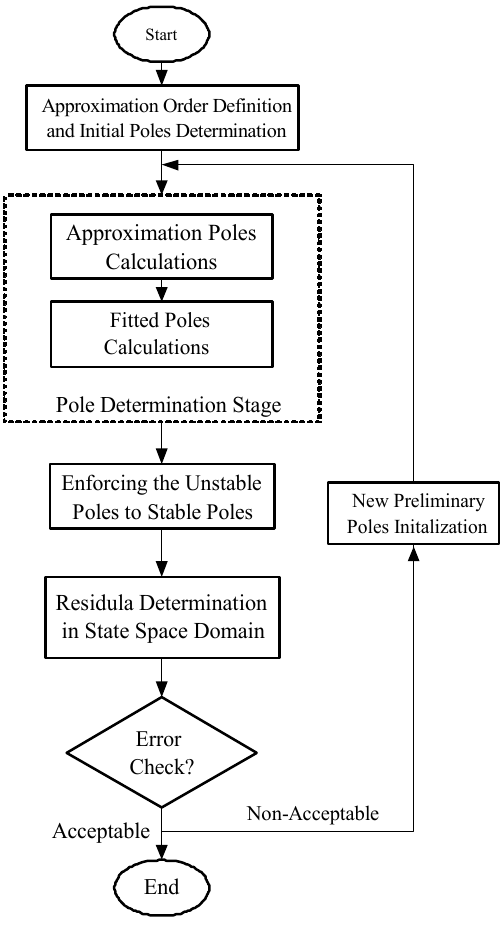
Figure 3. Fast relaxed vector fitting (FRVF) flowchart diagram.